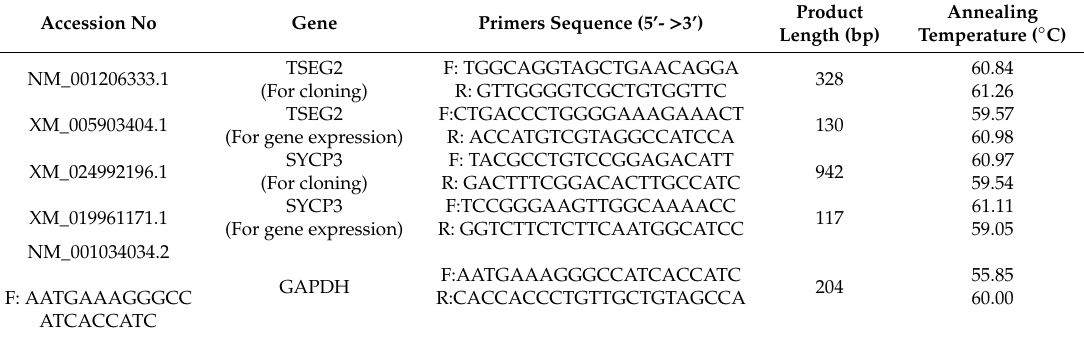
Table 1. Primers for qPCR and cloning were designed based on bovine genomic